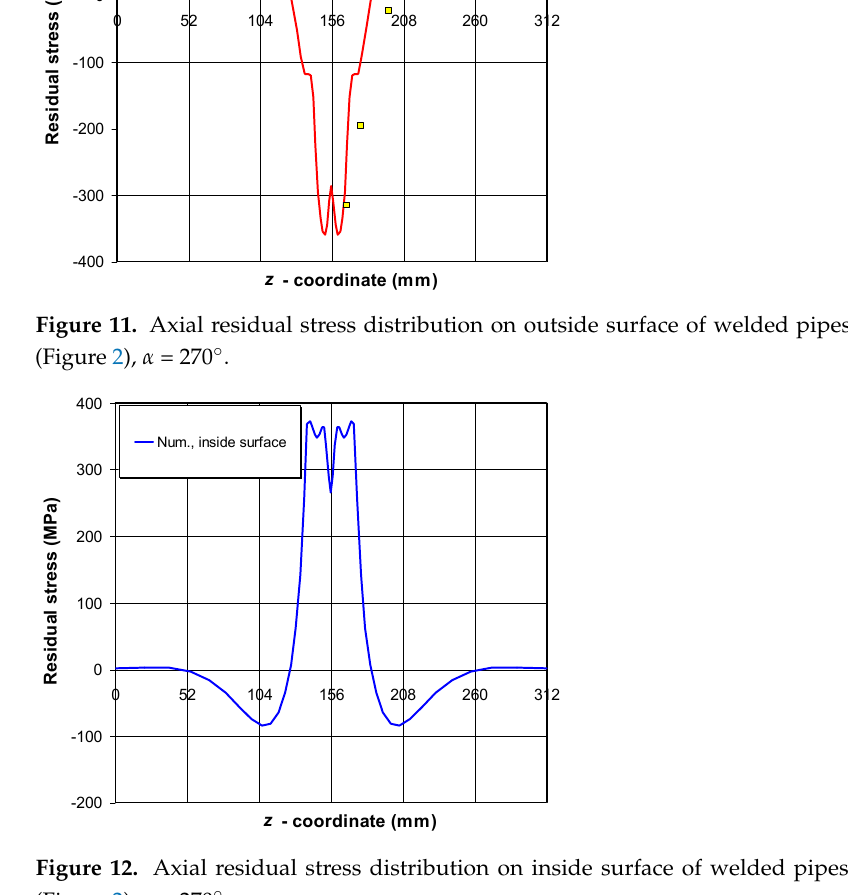
Figure 12. Axial residual stress distribution on inside surface of welded pipes along line z 1- z 2 (Figure 2), α = 270°.